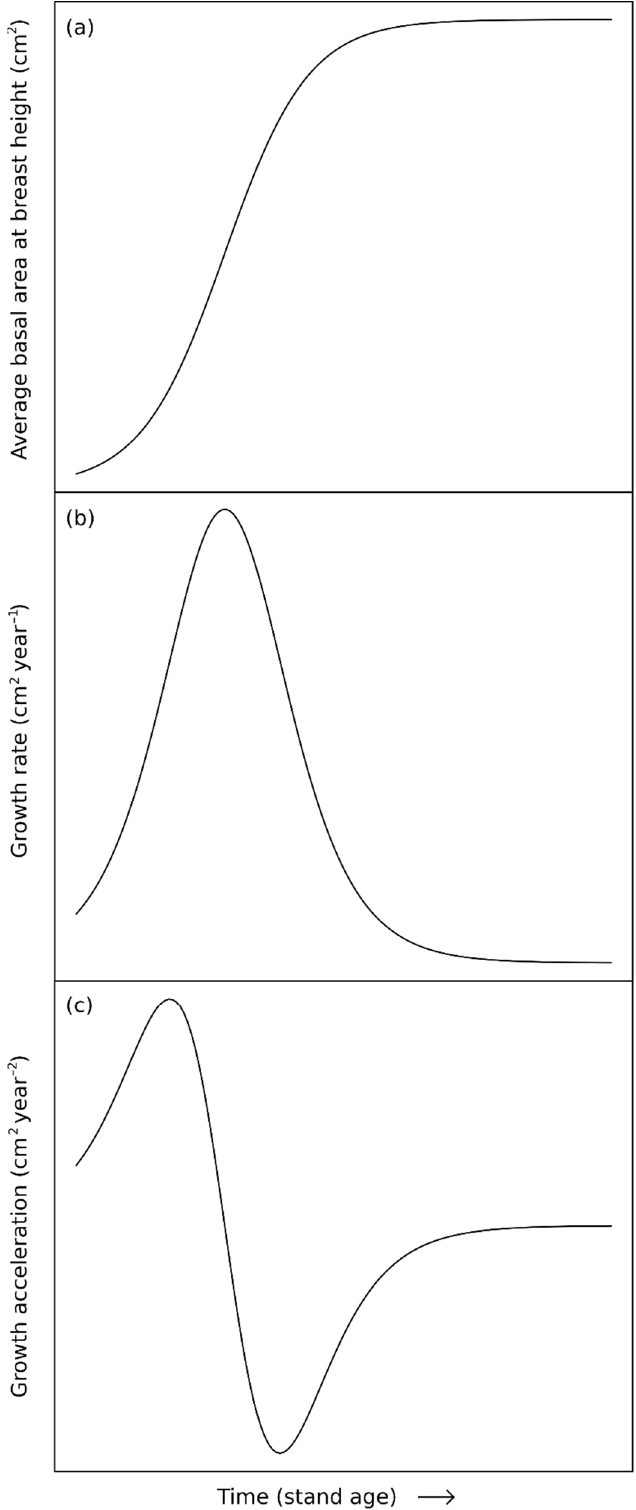
Figure 1. An example of the growth rate model (Equation (3)) ( a ) and its first ( b ) and second ( c ) derivatives. The sigmoid growth model ( a ) indicates cumulative growth for the investigated variable as a direct value. Here, the average basal area is a function of time. The first derivative ( b ) indicates the growth rate (physical speed) and achieves the maximum in the inflexion point of the growth model (Equation (3)). After that, the growth rate starts to decrease. The second derivative ( c ) is a speed of shift in the growth rate (physical acceleration). The extrema of that function indicate maximum acceleration (upper asymptote) and deceleration (lower asymptote).